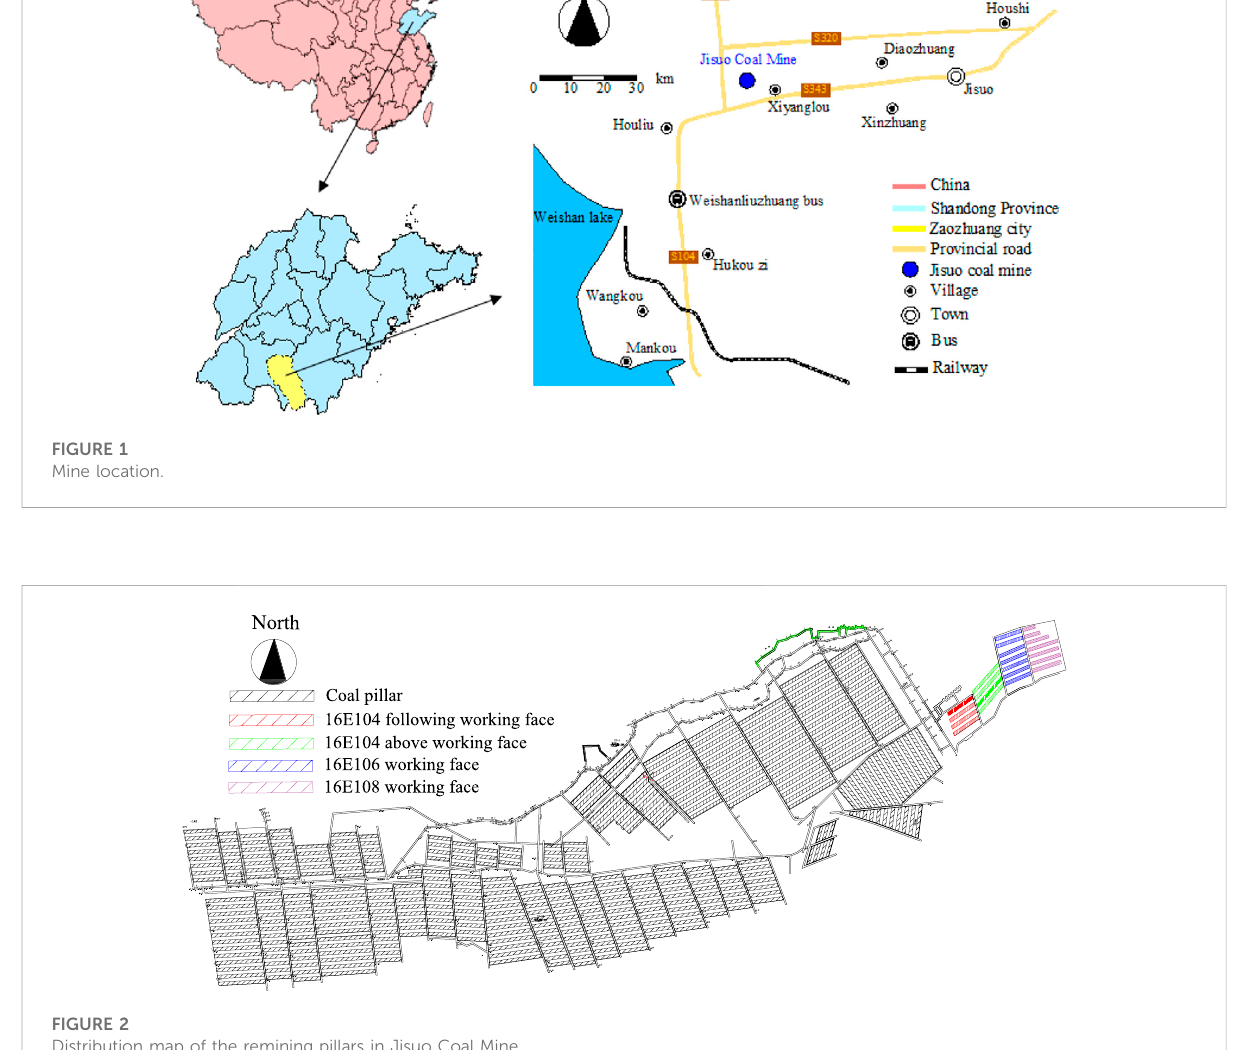
FIGURE 2 Distribution map of the remining pillars in Jisuo Coal